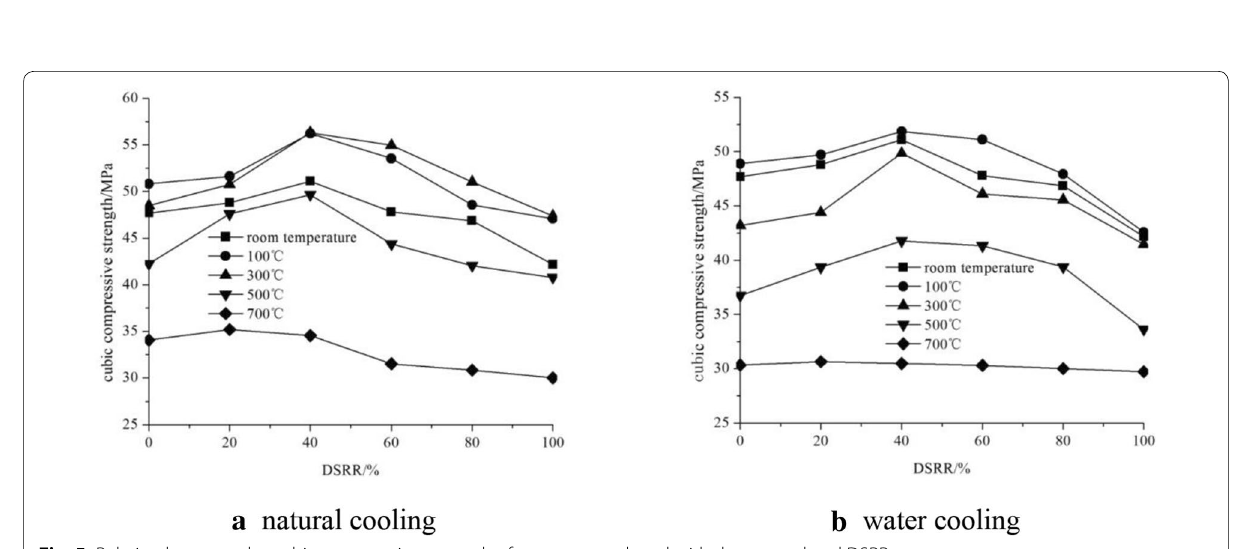
Fig. 5 Relation between the cubic compressive strength of concrete produced with desert sand and